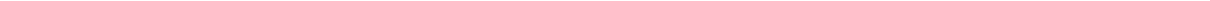
Fig. 5 Degradation of radical ion pairs. a UV – vis absorption difference spectra of a deaerated THF solution containing 3.0 mM H and 100 μ M Ir4 during continuous photoirradiation using a 300 W Xenon lamp for 10 min. b UV – vis absorption difference spectra of a vacuum evaporated thin fi lm of H molecularly doped with 15 wt % Ir4 during continuous photoirradiation using a 300 W Xenon lamp for 10 min. c UV – vis absorption difference spectra of a spincoated poly(methyl methacrylate) fi lm molecularly doped with 15 wt % Ir4 during continuous photoirradiation using a 300 W Xenon lamp for 10 min. d Evolution of liquid chromatograms taken for the THF solution containing 3.0 mM H and 100 μ M Ir4 during the continuous photoirradiation using a 300 W Xenon lamp for 10 min. e Comparison of the liquid chromatograms of the THF solution of 3.0 mM H and 100 μ M Ir4 before (black) and after (magenta) the photoirradiation (10 min). The peaks marked with asterisks were byproducts and subjected to mass analyses. f Electrospray mass spectrum (positive mode) of the photolyzed THF solution containing 3.0 mM H and 100 μ M Ir4. The inset structures correspond to the observed m / z values (a.m.u.). The inset graph shows a comparison of the isotopic distribution of the peak at m / z 827.39 (black bars) with theoretical values calculated for the structure shown on the left (magenta bars). g Electrospray mass spectrum (positive mode) of an oxidatively electrolyzed THF solution of 2.0 mM Ir4. The inset structures correspond to the observed m / z values